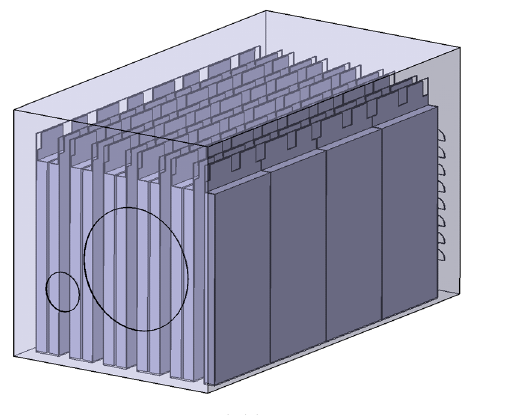
Figure 1. Simplified 3D model of a power battery pack.